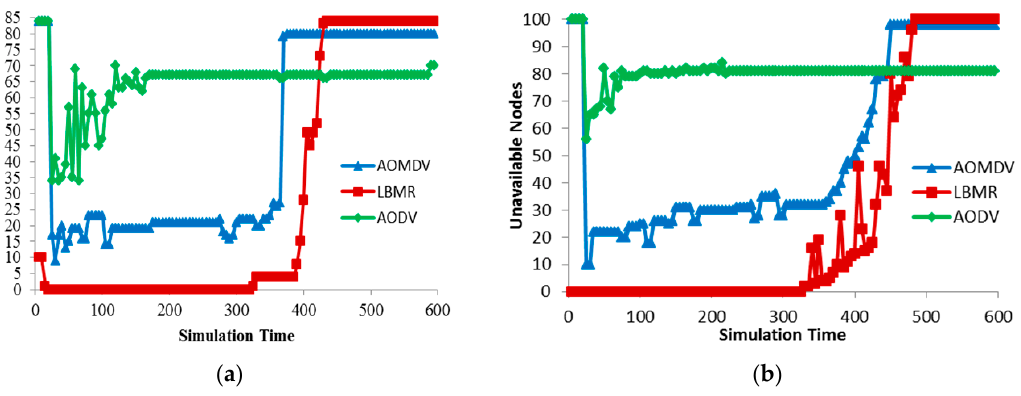
Figure 8. Route maintenance. ( a ) Grid topology (total nodes is 85); ( b ) Random topology (total nodes is 100).